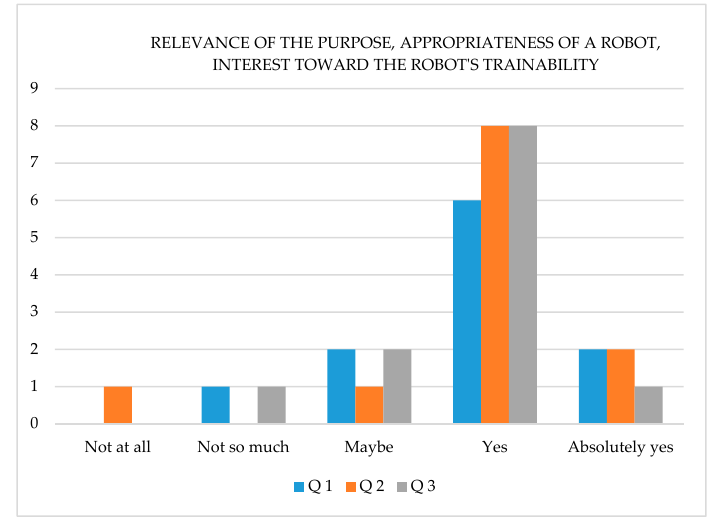
Figure 3. The figure shows the results of the first three questions of the questionnaire submitted to parents. The list of numbers on the left axis of the graphs indicates the number of parents.